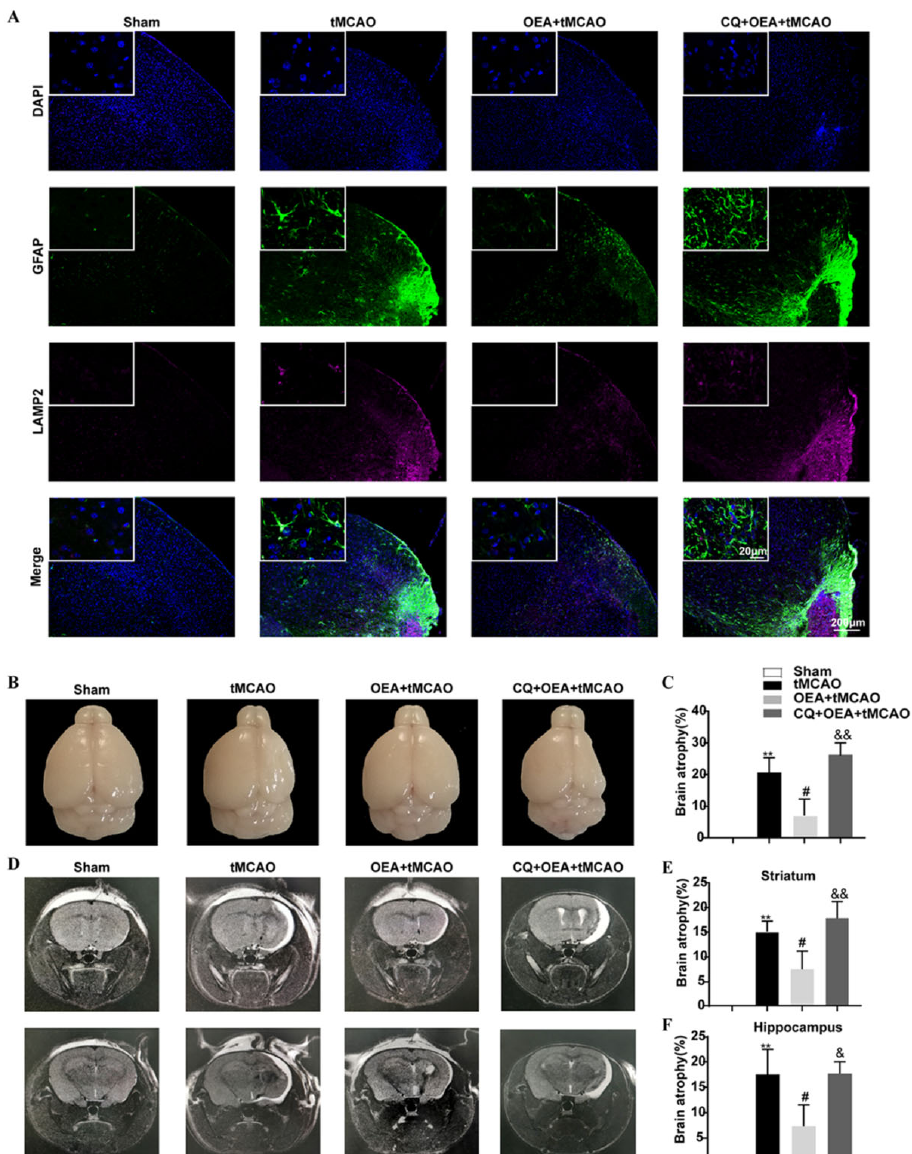
Figure 6. Chloroquine antagonizes the protective effect of OEA on chronic brain ischemic injury in mice. ( A ) The representative photographs of immuno fl uorescence staining for GFAP (green) and LAMP2 (purple) expressions in the ischemic boundary zone of brain sections after the administra- tion of CQ (50 mg/kg/2 d, i.p. administration from 3 days before surgery to 14 d after tMCAO), with or without the treatment of the PPAR α agonist OEA (30 mg/kg/d, i.p. administration from 3 days before surgery to 14 d after tMCAO) at day 14 after tMCAO. The high-magni fi cation images of the reactive astrocytes in the boundary zone are shown in the inserts. ( B , C ) The representative photo- graphs and quantitative analysis of the degree of brain atrophy after tMCAO with the administra- tion of OEA, with or without CQ. ( D – F ) The representative T2-weighted MRI images and quantita- tive analysis of brain atrophy degree at striatum and hippocampal levels. Data are expressed as the mean ± SEM, n = 3 mice, ** p < 0.01 vs. sham group; # p < 0.05 vs. vehicle-treated tMCAO group; & p < 0.05, && p < 0.01 vs. OEA-treated tMCAO group.